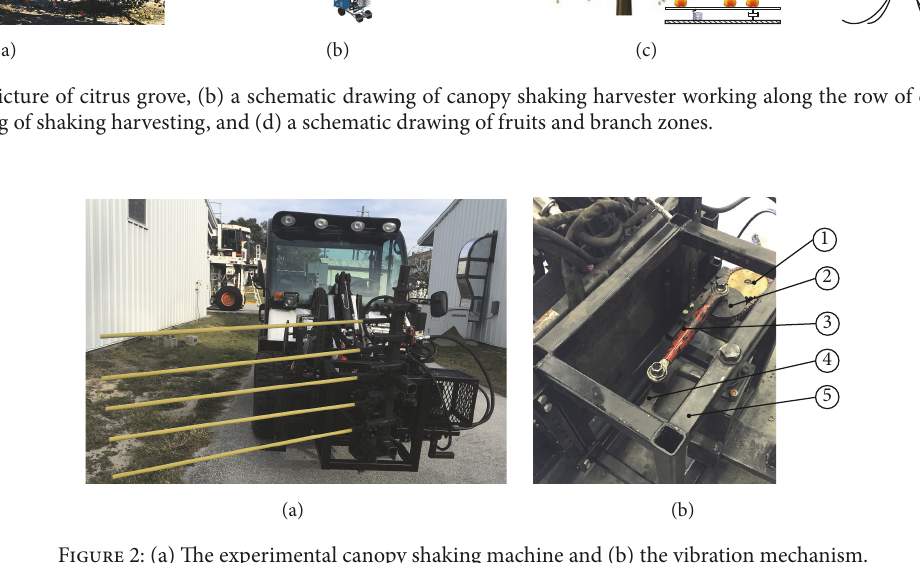
Figure 2: (a) The experimental canopy shaking machine and (b) the vibration